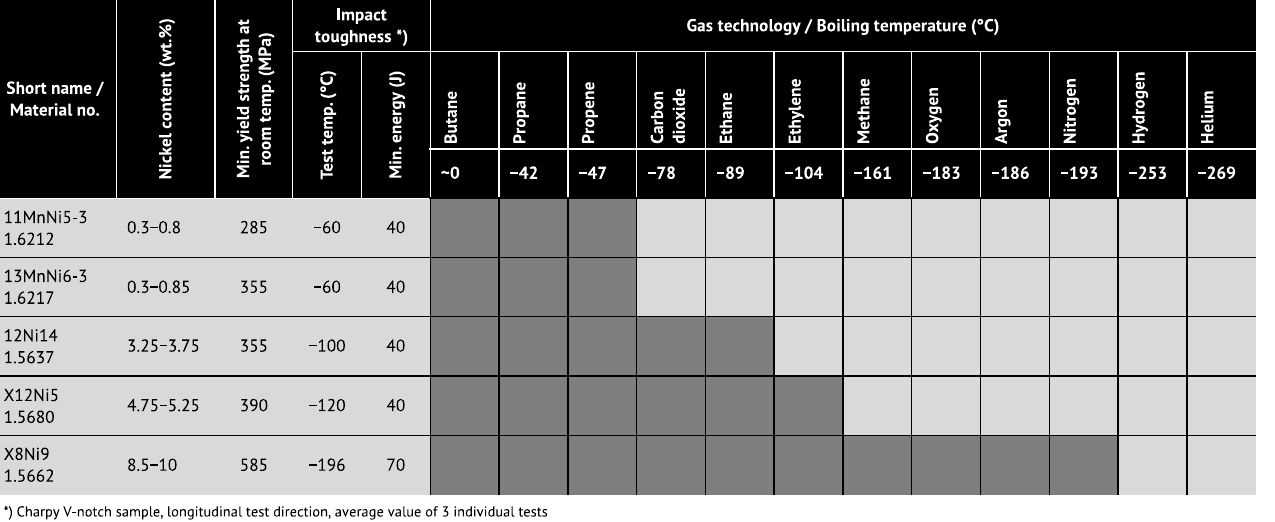
Figure 14. Properties and application ranges of nickel ‐ alloyed cryogenic steels for liquefied gas technology.